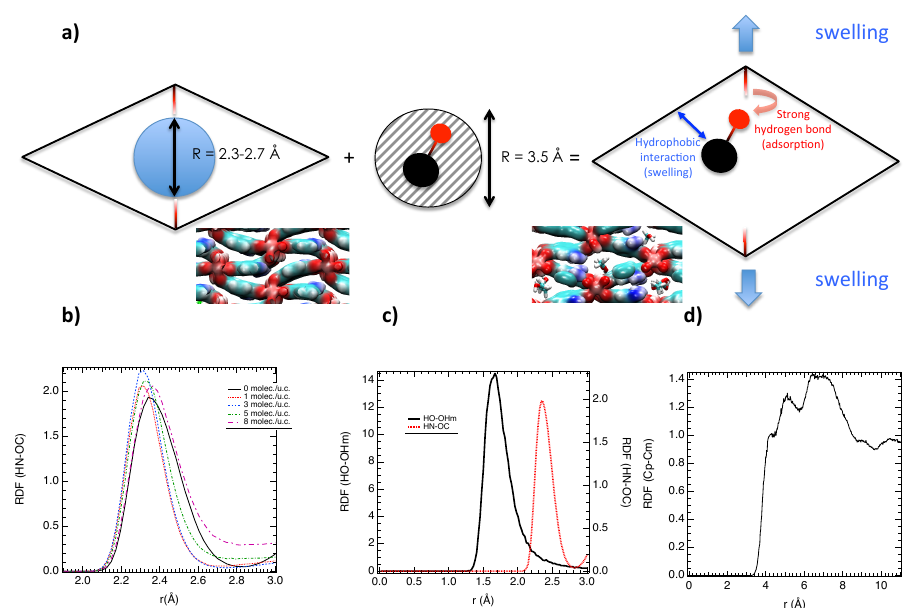
Figure 8. ( a ) Scheme illustrating the swelling from the adsorption of the MeOH molecule in the empty NH 2 -MIL53(Al); ( b ) Radial distribution functions between HN and OC for 0, 1, 3, 5 and 8 molec./u.c. at 300 K; ( c ) Radial distribution functions between the oxygen atom of the hydroxyl group of MeOH (Om) and HO and between HN and OC for 8 molec./u.c. at 300 K; ( d ) RDF between the carbon atoms of the benzenic groups of the MOF (Cp) and the carbon atoms of MeOH (Cm) at 300